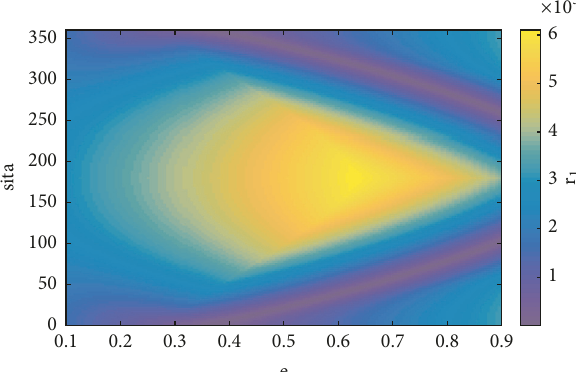
Figure 6: Closest distances between the spacecraft and the Moon corresponding to different initial phases and eccentricities for the 1:2 resonant